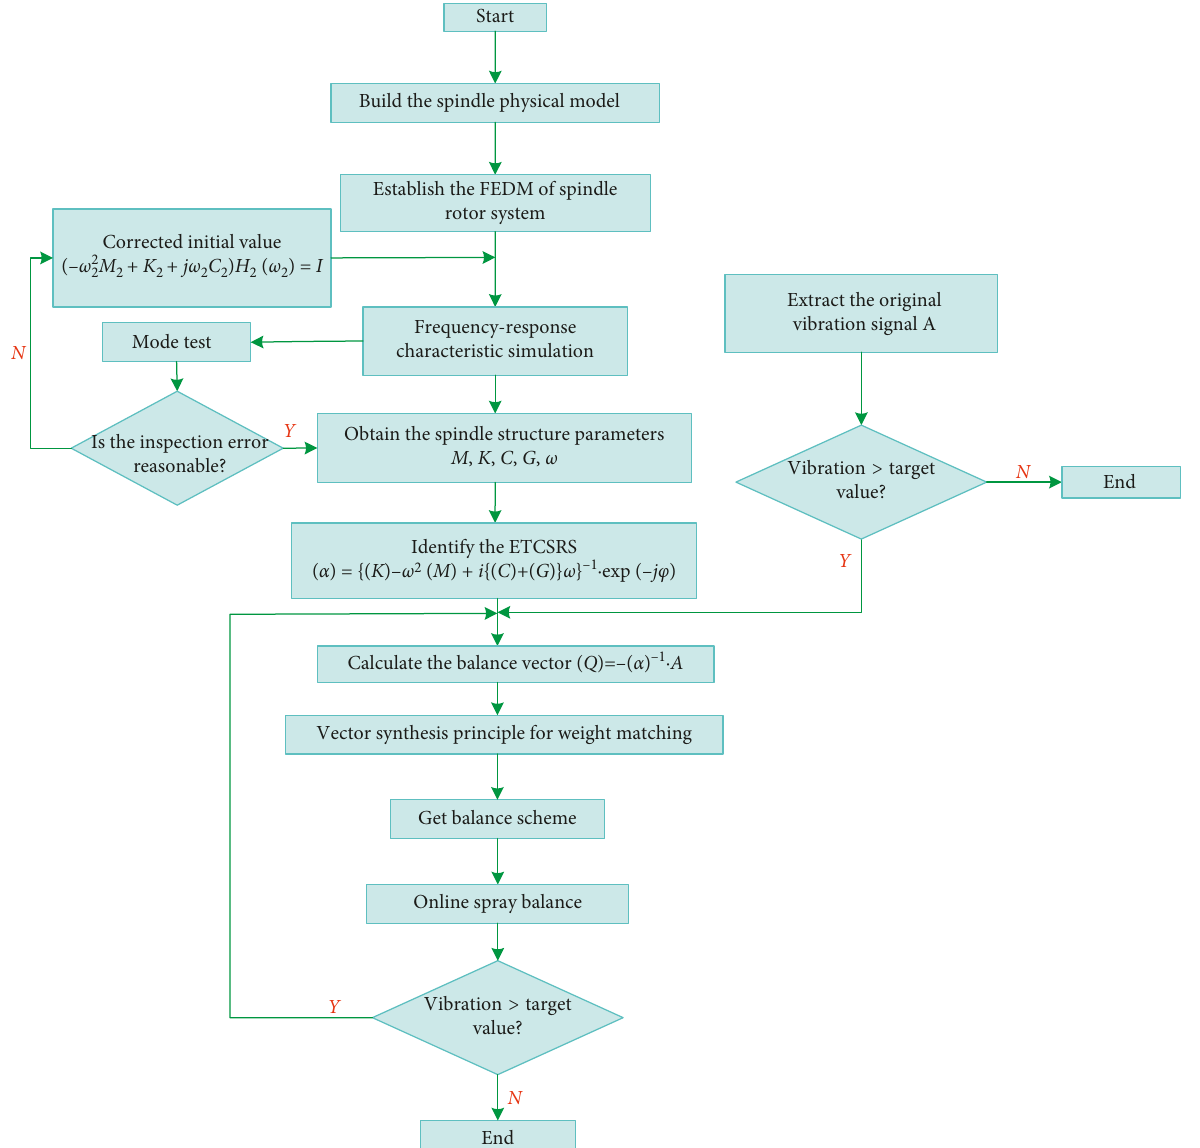
Figure 15: The balance